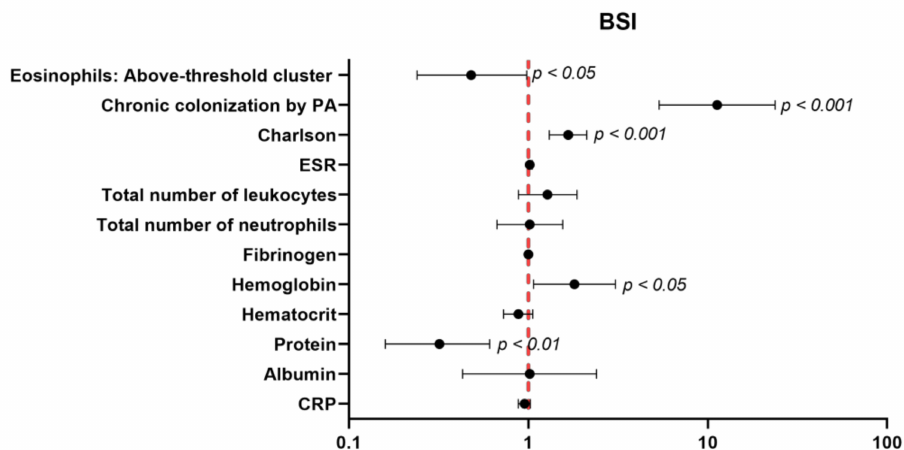
Figure 5. The independent association of dichotomized eosinophils with severe BSI. A multivariate regression analysis was used to perform the analysis. The confidence intervals and statistical significance are represented in the figure panel. The odds ratio is represented as black dots. The model was adjusted by chronic colonization by the PA, Charlson Index, ESR, total number of leukocytes, total number of neutrophils, fibrinogen, hemoglobin levels, hematocrit levels, protein, albumin, and CRP